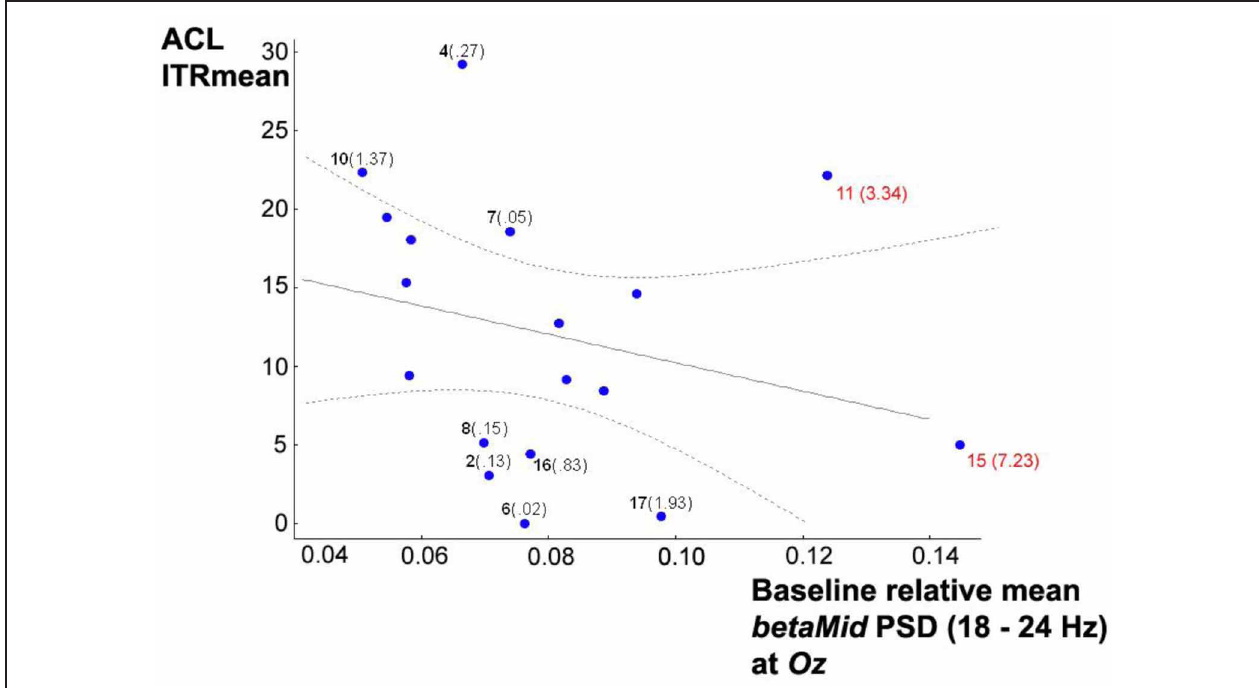
ITR Mean as criterion variables and relative mean betaMid PSDs as predictor variables. Subject 15 and 11 (in red) might be considered as outliers (see text). Excluding them changes the Pearson correlation from r = − 0 . 262, p = 0 . 294 to significant r = − 0 . 510, p = 0 .